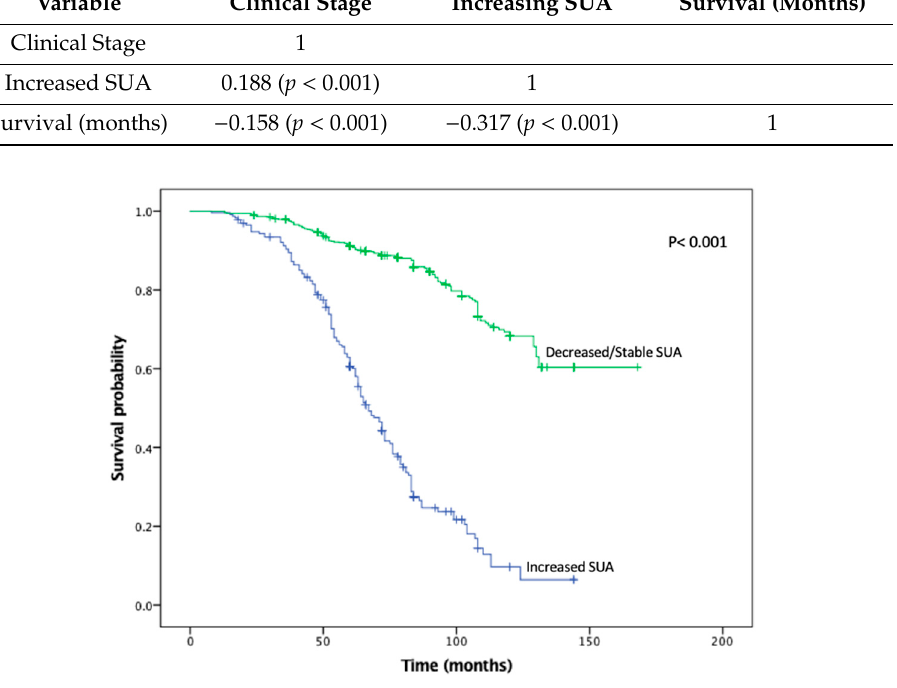
Figure 1. Kaplan-Meier plot for overall survival in the stable/decreased uric acid and increased uric acid groups.